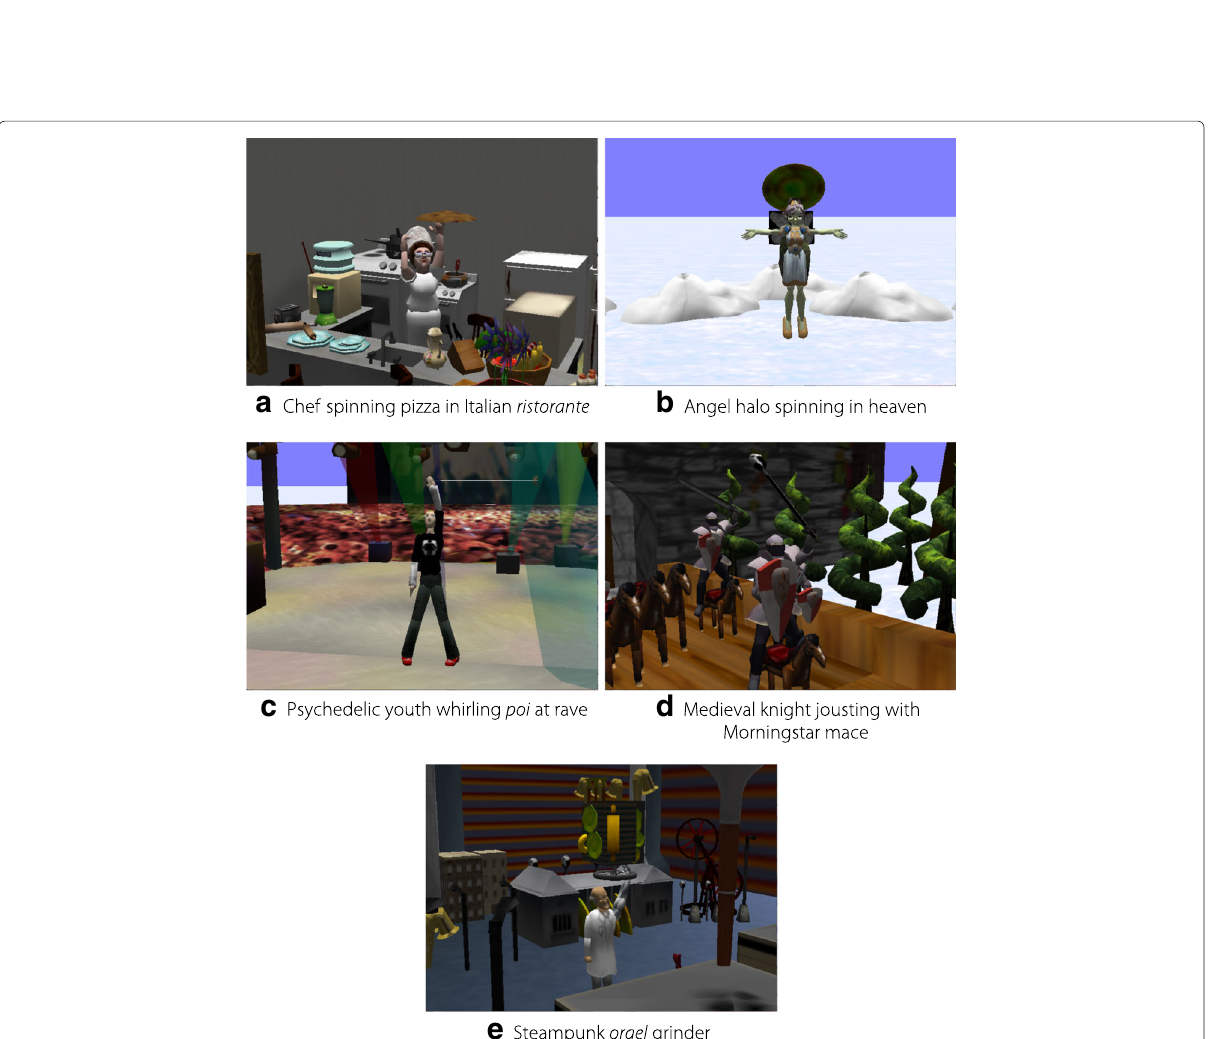
Fig. 12 Augmented virtuality twirling fantasy scenes, rigged for mobile affordance modulation (first generations of respective